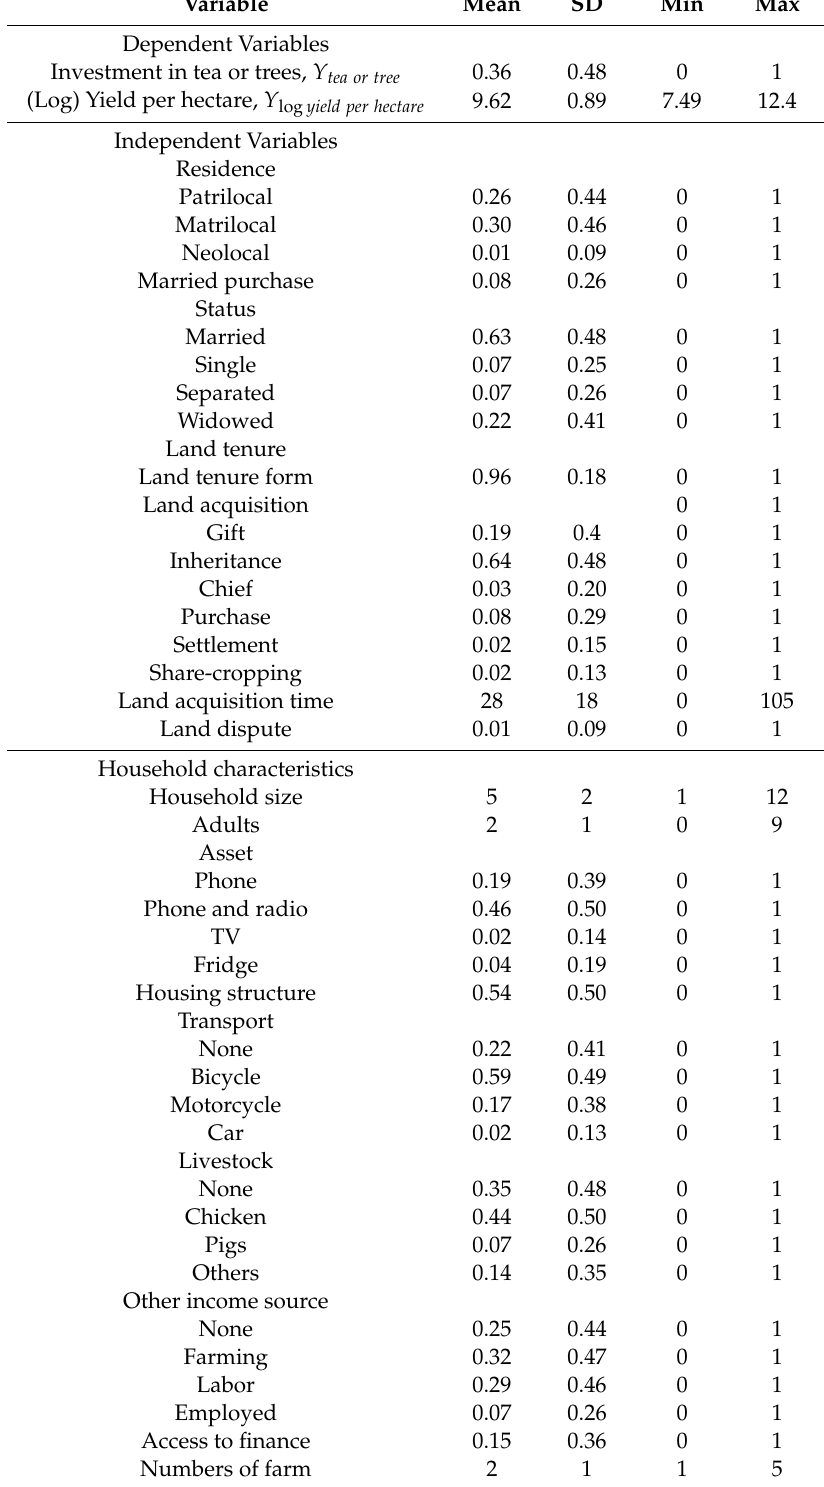
Table 3. Descriptive statistics of relevant